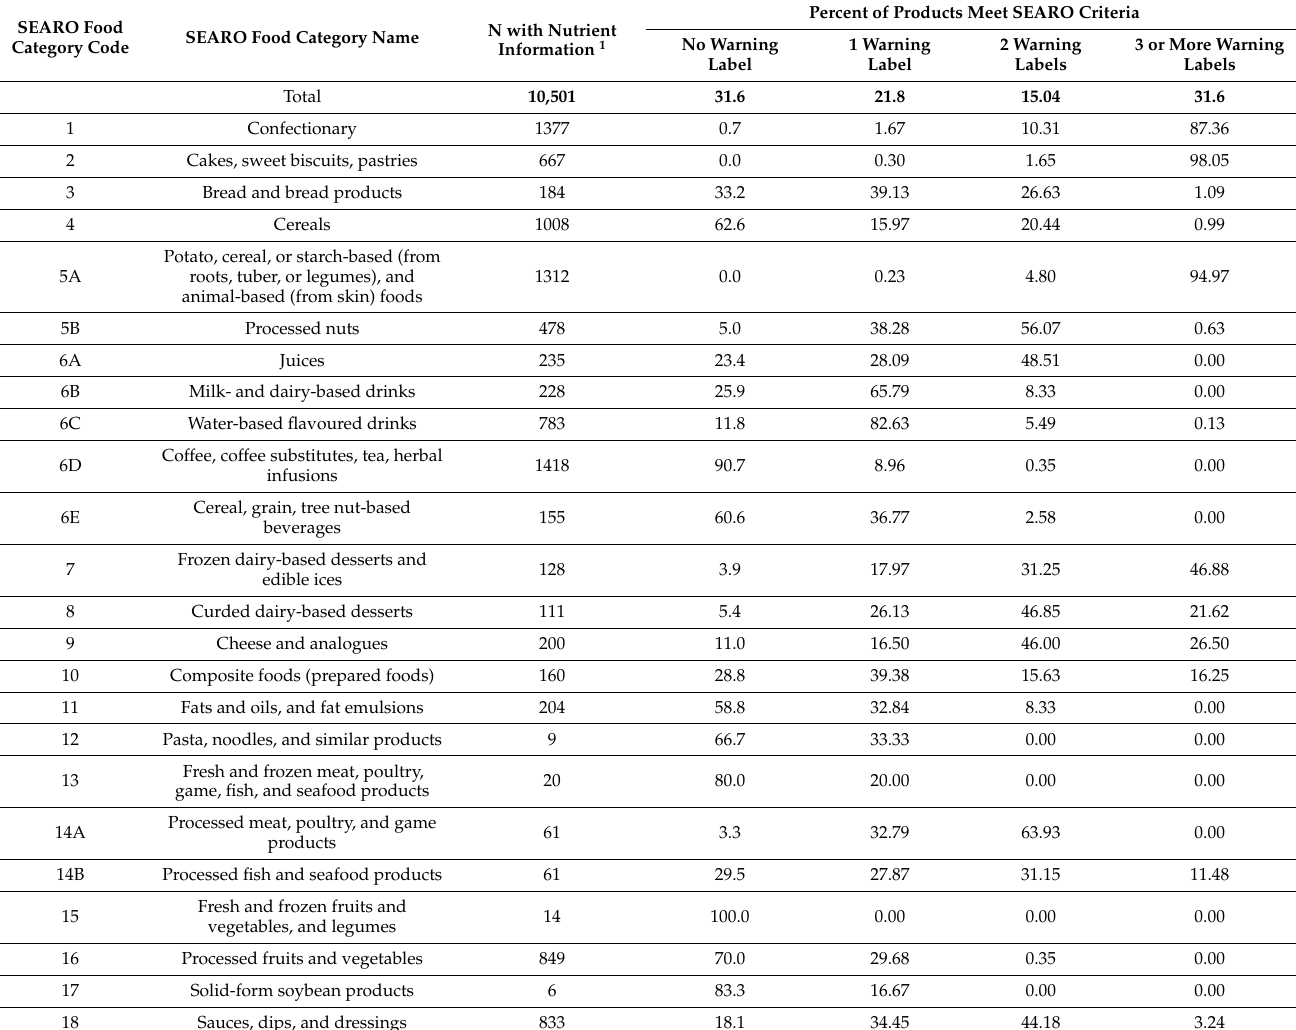
Table 2. The percentage of foods and beverages meeting the WHO South-East Asia Region Organization (SEARO) nutrient profile modeling criteria for one or more warning labels, by SEARO food category. SEARO Food Category